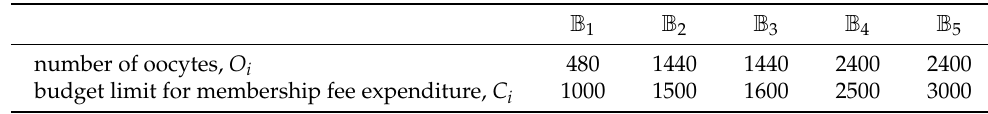
Table 1. Data of the five ICEBs to form an alliance. number of oocytes, O i 480 1440 1440 2400 2400 budget limit for membership fee expenditure, C i 1000 1500 1600 2500 3000 Table 2. Parameters of Coalition for Egg Banking. Parameter Value total number of ICEBs in A , I 5 average number of blocks generated by an oocyte, N 60 weighting factor for satisfaction function, α 10.0 weighting factor for utility function for profit, β 8.0 percentage of membership fees allocated for rebate, ρ constant coefficient of the satisfaction function, a constant coefficient of the participation function, b constant coefficient of the membership fee function, m , n 500.0, 5.0 constant coefficient of the utility function for profit,